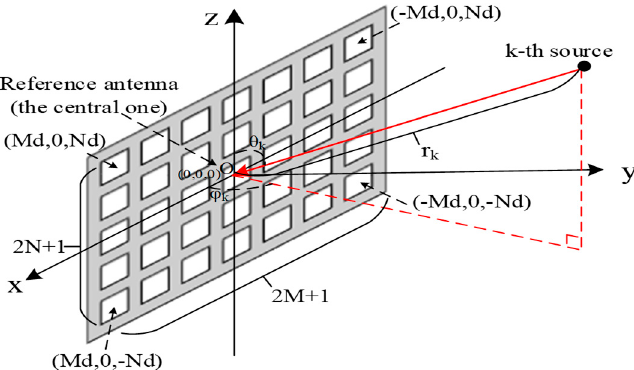
Figure 1. Spherical wavefront propagation model in the near-field condition.